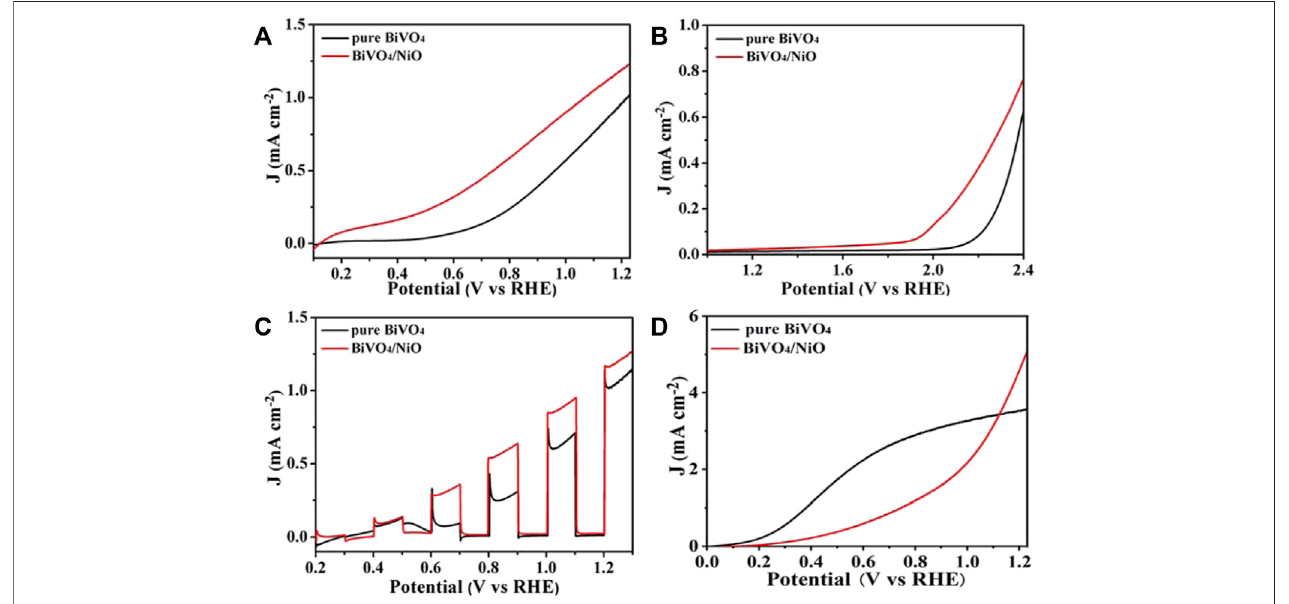
FIGURE 3 | (A) Photocurrent density-voltage curve of BiVO (B) Photocurrent density-voltage curve of BiVO 4 and BiVO 4 /NiO photoanodes. 4 and BiVO 4 /NiO photoanodes in the absence of light. (C) Chopped linear sweep photocurrent-potential curve of BiVO 4 and BiVO 4 /NiO. (D) Sul fi te oxidation current curves.